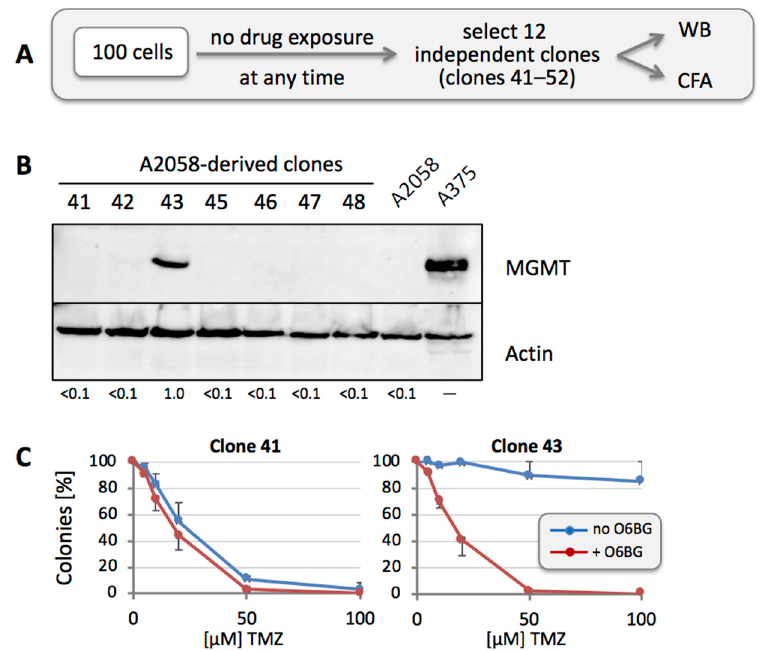
Figure 5. MGMT protein levels in clones derived from untreated A2058 cells. ( A ) Treatment schedule was as follows: 100 A2058 cells were seeded into a 10-cm dish. After colonies had formed (in the absence of any drug treatment), 12 of them (numbered 41 through 52) were isolated and expanded for further analysis by WB and CFA. ( B ) Cell lysates were prepared from all clones and analyzed by WB for MGMT protein levels. Actin was used as a loading control. A lysate of A375 cells was used as a positive control for MGMT protein, and a lysate of parental A2058 cells was used as the negative control. Except for clone 43, all clones were negative for MGMT protein (clones 49 to 52 were negative as well, but not included here; clone 44 was lost). Numbers under the blot indicate quantification of MGMT bands, with reference to the actin signal, and relative to Clone 43 (set at 1.0); <0.1 indicates below detection limit. ( C ) To confirm drug sensitivity in correlation with MGMT levels, clone 41 and 43 were treated with increasing concentrations of TMZ in the presence or absence of O6BG, and CFA was performed 12 days later ( n = 3, ±SE).